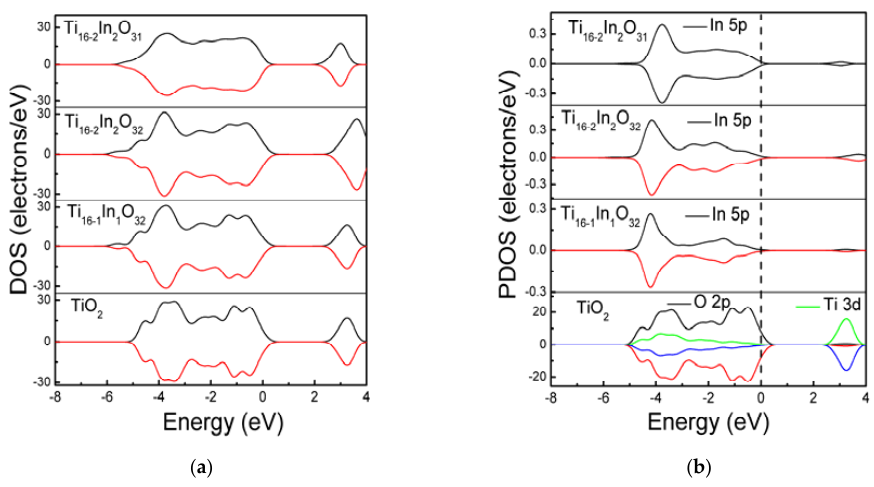
Figure 3. The ( a ) total density of states and; ( b ) partial density of states.